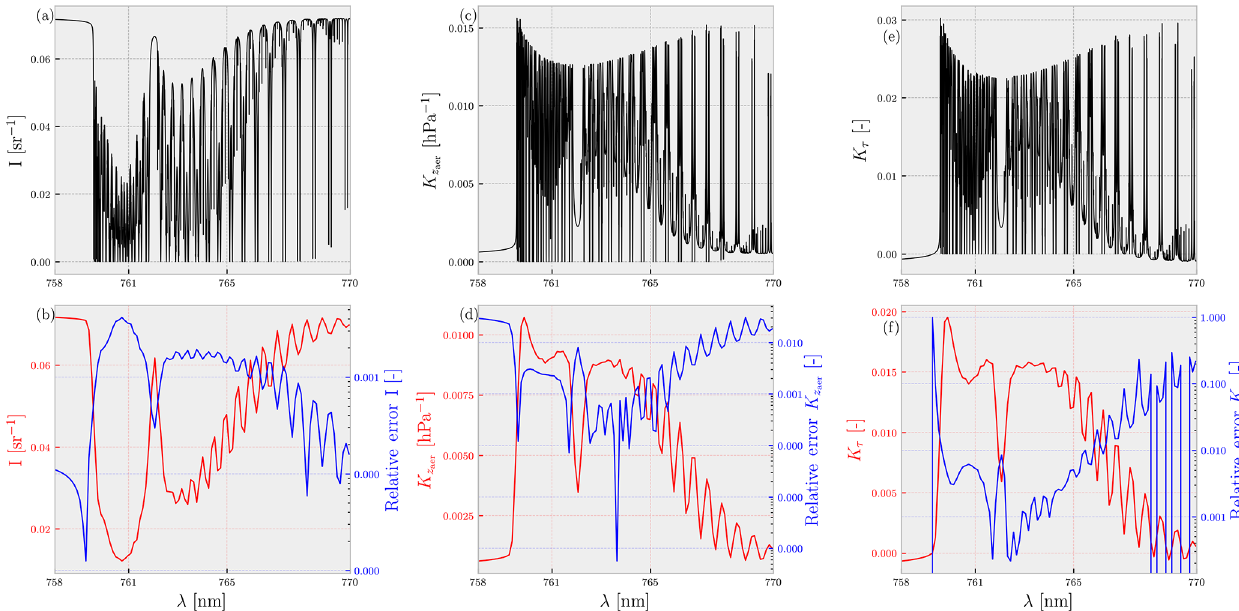
Figure 4. Performance of the finalised neural network. Panels (a) , (c) , and (e) represent the averaged output of each of the neural networks for surface albedo less than 0.4. Panels (b) , (d) , and (f) represent the convolved version of (a) , (c) , and (e) (plotted as the red line read from the left-hand y axis) and the convolved relative error (plotted in log scale) with the truth (plotted in blue and read from the right-hand y axis). The relative errors are computed as the absolute value of the difference (post-convolution) between the averaged true and averaged predicted spectra, divided by the averaged true spectra. Panels (a) and (b) represent the neural network computed sun-normalised radiances, panels (c) and (d) represent the same for the derivative of reflectance with respect to the aerosol layer height, and panels (e) and (f) represent the same with respect to the aerosol optical